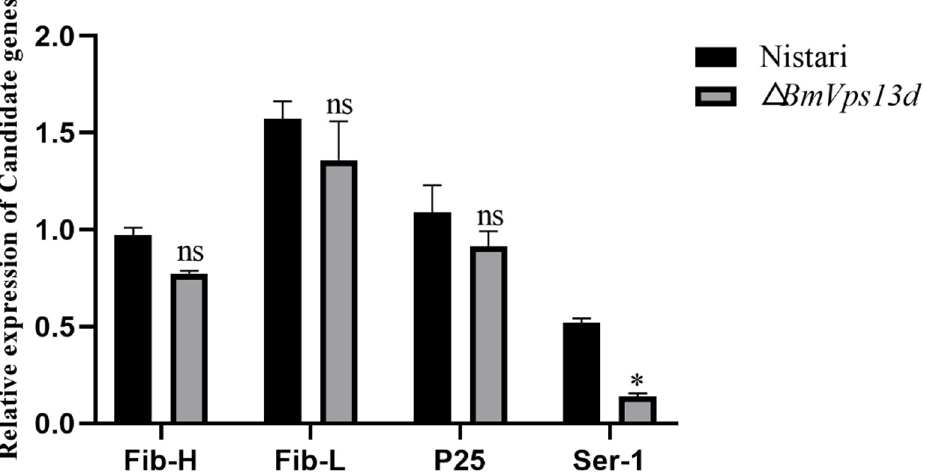
Fig 8. The relative expression levels of silk protein genes were detected by RT-qPCR in 4 BmVps13d mutant and Nistari strain. The histograms show the relative transcript levels of silk protein genes. Nistari (black) 、 4 BmVps13d (grey). All data are representative of three independent experiments and are expressed as the mean ± standard error of the mean (SEM). A two-tailed t -test is used to evaluate gene expression difference in midgut, silk gland, and fat body between JS and L10 at the third day of fifth instar larval stage. P -values are described as follows: � P � 0.05, �� P � 0.01, ��� P �